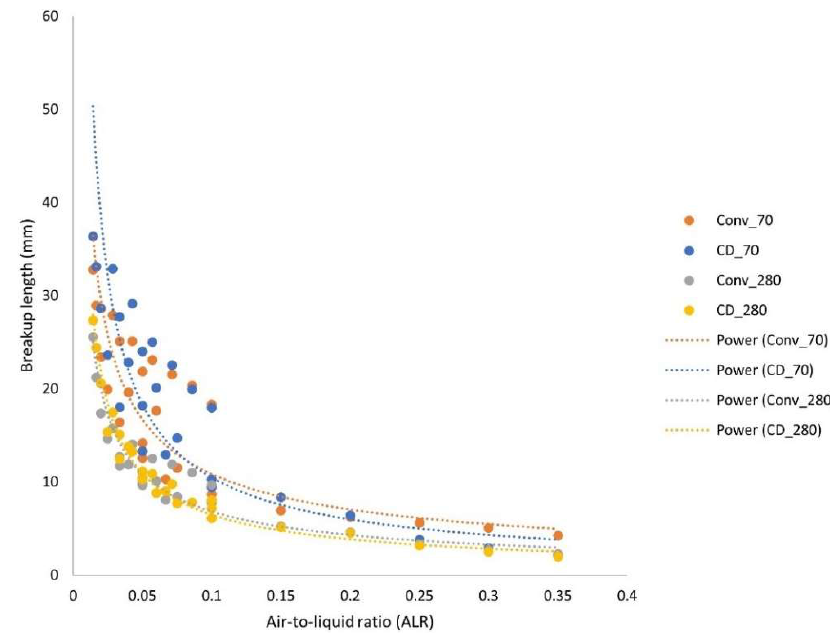
12 of 15 Figure 14. Breakup length measurement for both the converging and CD atomizer for two cases: ( a ) 70 µm sheet thickness and ( b ) 280 µm sheet thickness. The breakup length was plotted (Figure 15) against airflow rates for both 70 µm sheet thickness and 280 µm sheet thickness for the converging and CD atomizer, respectively. The breakup length follows an inverse relationship with the air-to-liquid ratio (ALR). For